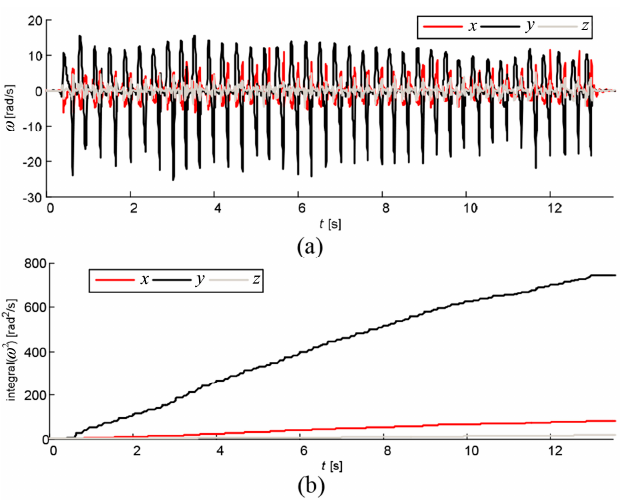
Figure 2. Angular velocity of thumb observed from coordinate system of index finger: ( a ) instantaneous components; and ( b ) integrated squared components.